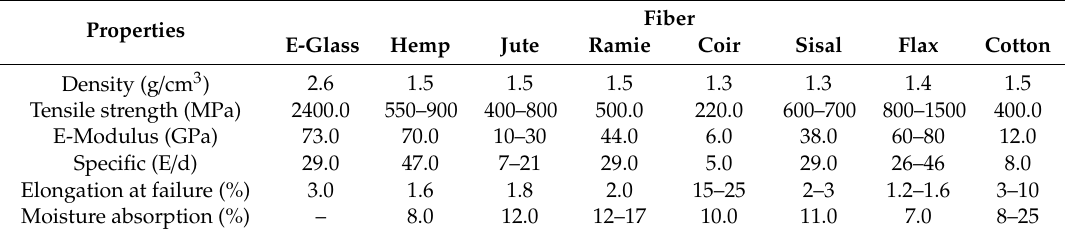
Table 11. Material properties of selected fibers incorporated into FRPs [24].